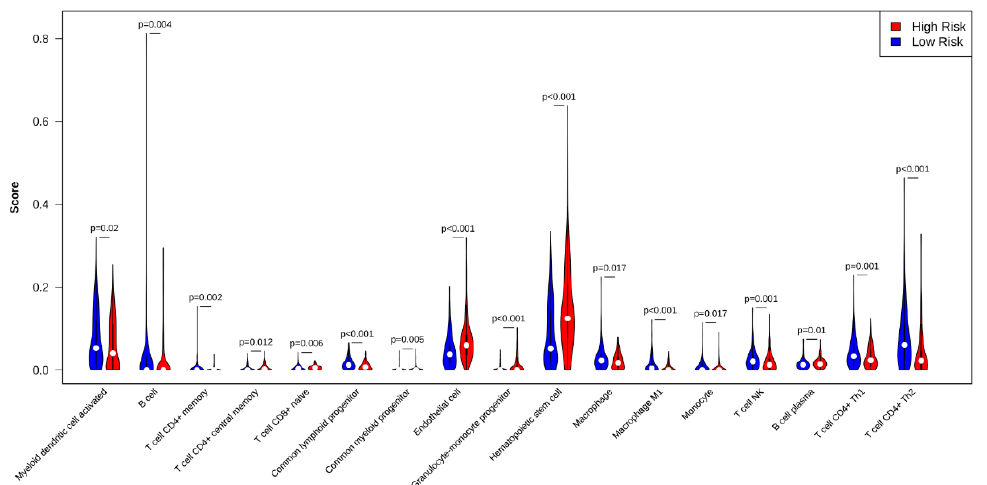
Figure 9. Comparison of tumor-infiltrating immune cells between the risk subgroups of the TCGA- LIHC dataset.